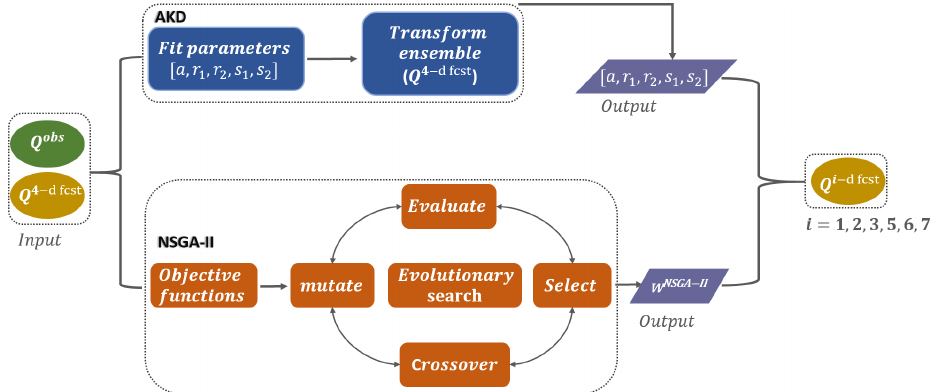
Figure 3. Schematic of the experimental setup flowchart.